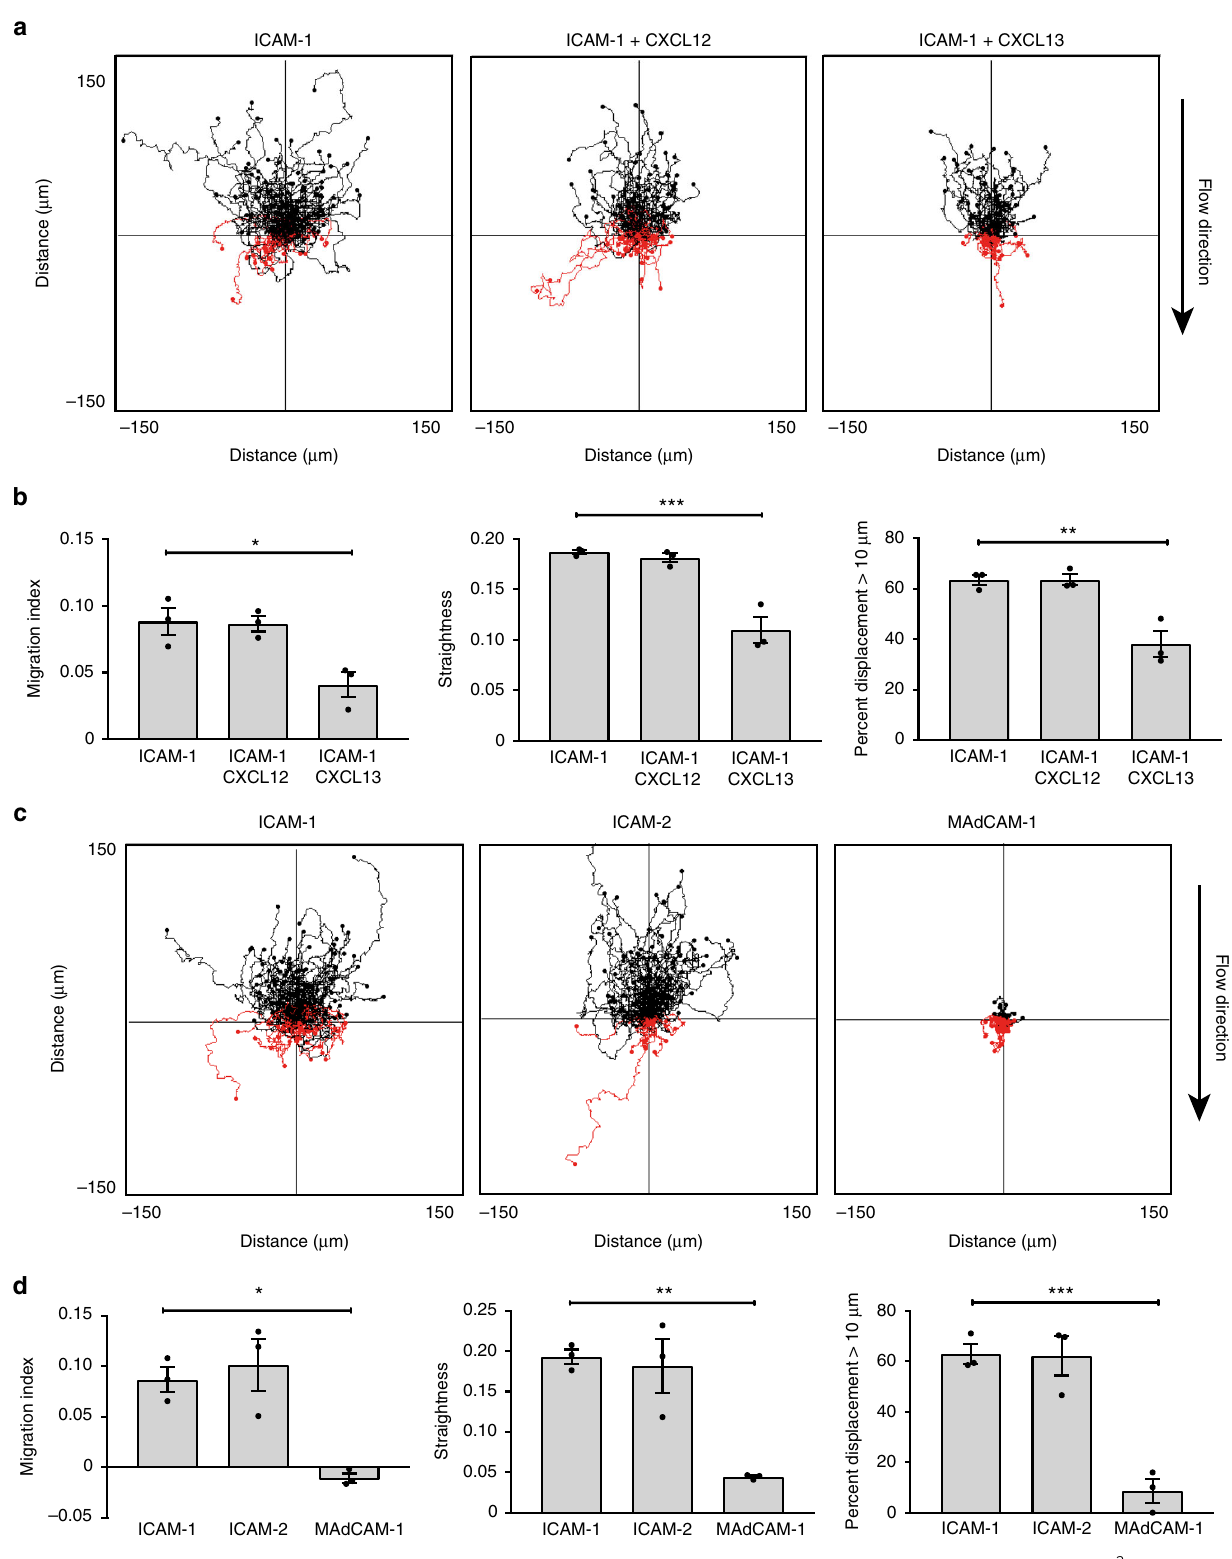
Fig. 3 CXCL13 and MAdCAM-1 inhibit MZB migration up the fl ow. a Representative track plots for MZB migrating up fl ow (3 dyn cm − 2 ) on ICAM-1 (5 µ g ml − 1 ) alone or in combination with coated CXCL12 (0.3 µ g ml − 1 ) or with CXCL13 (2 µ g ml − 1 ). b Quanti fi cation of migration index, straightness, and % of cells that displaced more than 10 µ m. All three graphs show different parameters from the same set of experiments; bars show mean ± SEM. Data are from three experiments with one mouse each. c Representative track plots for MZB migrating up the fl ow (3 dyn cm − 2 ) on ICAM-1 (5 µ g ml − 1